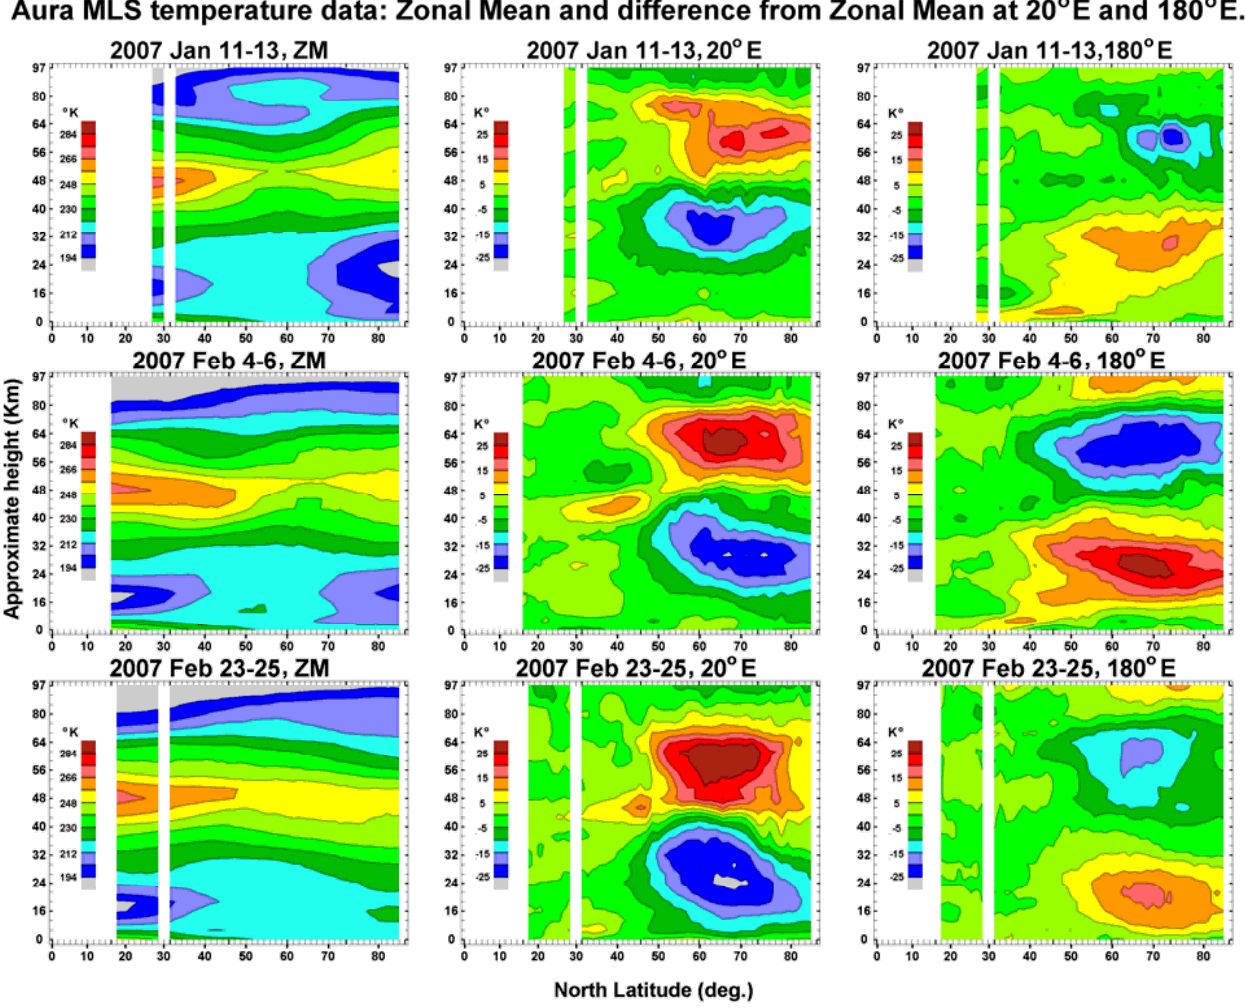
Fig. 5 Fig. 5. Height-latitude contour plots for MLS zonal mean temperature and differences from zonal mean at two longitudinal sectors for three time-intervals during winter 2006/2007. See text for